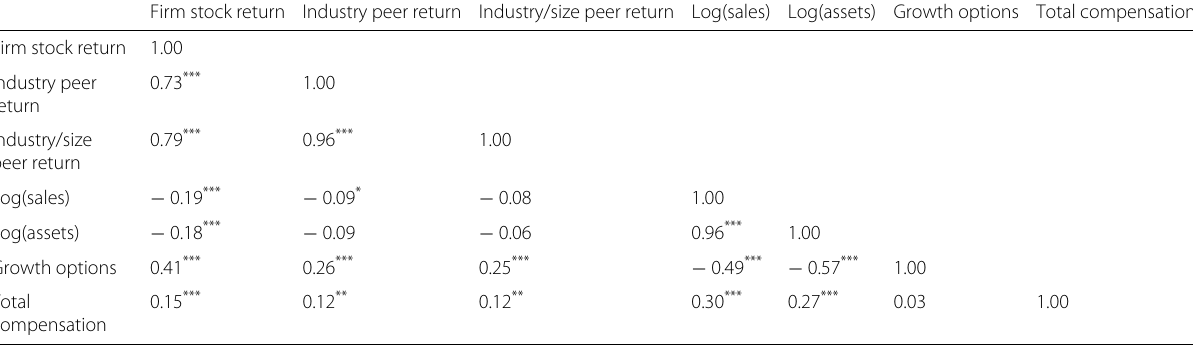
Table 2 Pearson correlation